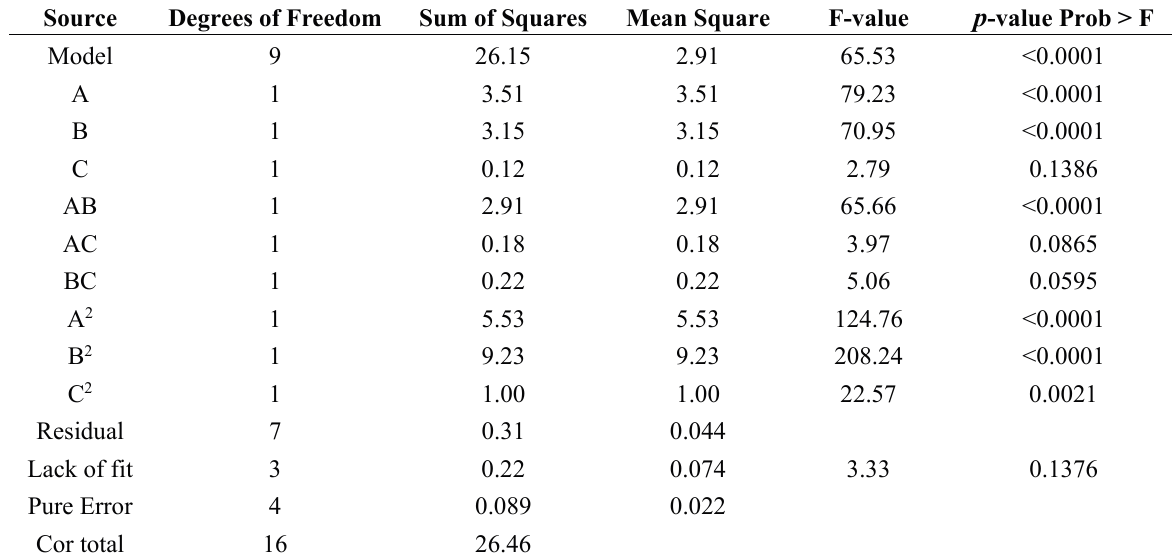
Table 2. Analysis of variance (ANOVA) for the quadratic response surface